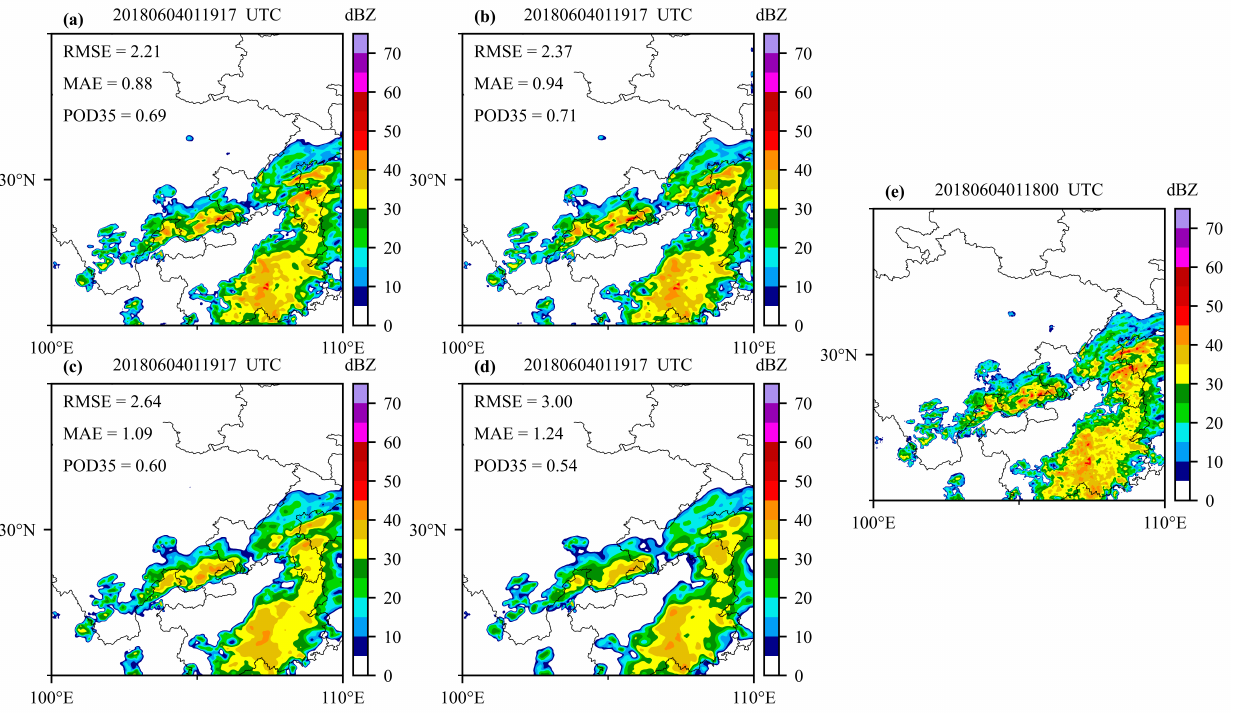
Figure 8. Reconstructed CREF based on satellite observation. ( a ) Attention U-Net VIS_IR model; ( b ) Attention U-Net IR model; ( c ) U-Net VIS_IR model; ( d ) U-Net IR model; ( e ) actual observed